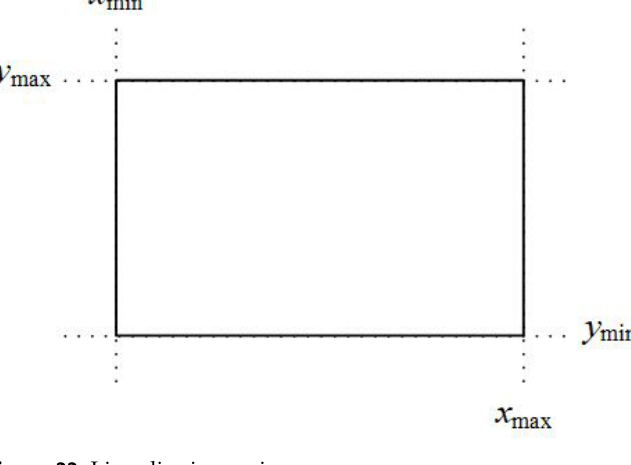
Figure 22. Line clipping